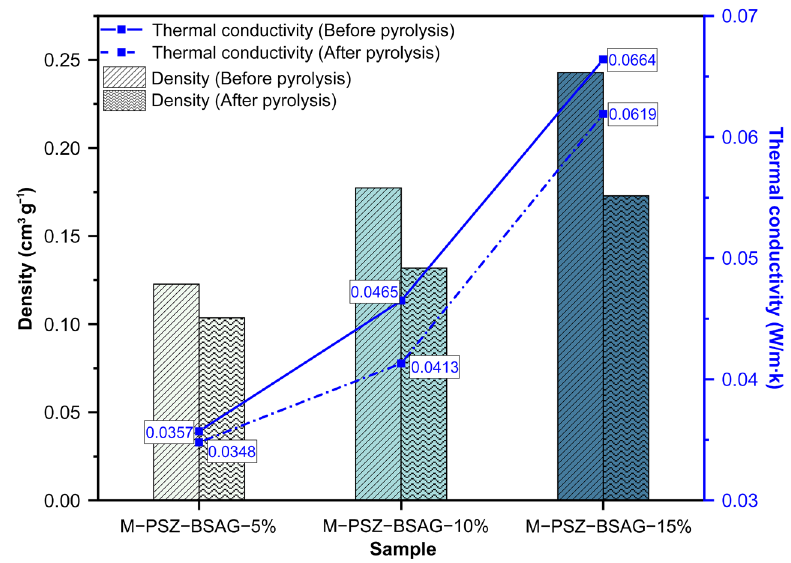
Figure 8. Density and thermal conductivity of aerogel composites prepared with different solution ratios before and after pyrolysis at 1000 °C.